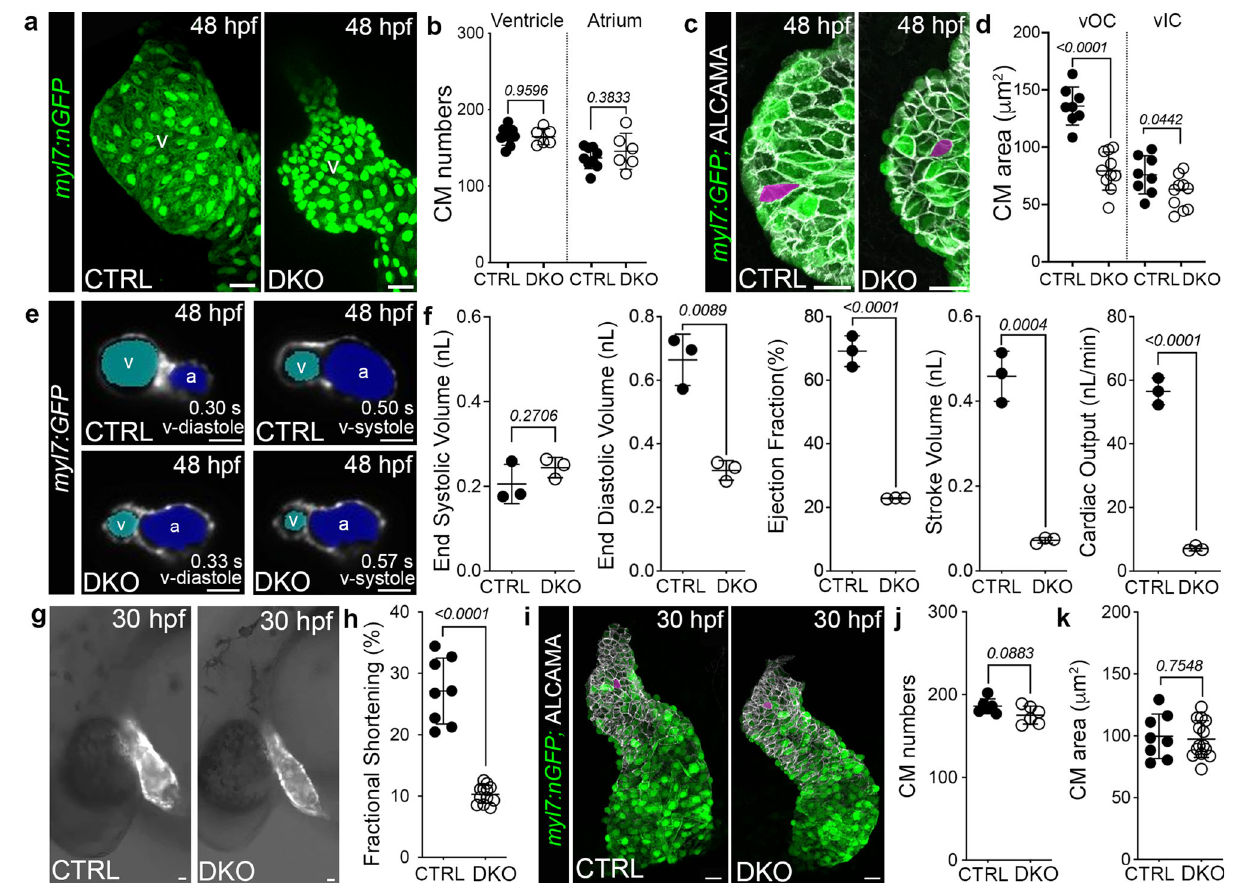
Fig. 3 | Impaired myocardial function is the earliest cardiovascular defect observedinRbfox-de fi cientembryos.a Confocalprojectionsof48hpfCTRLand DKO hearts carrying the Tg ( myl7:nGFP) transgene immunostained for GFP (green). b Dot plot showing cardiomyocyte numbers. c Confocal projections of 48hpf ventricular OCs from CTRL and DKO embryos carrying the Tg ( myl7:GFP) reporter immunostained for GFP (green) and ALCAMA (white). Magenta overlay of OC cardiomyocytes. d Dot plot showing the average area of ventricular OC and IC cardiomyocytes. e Single-plane images of 48hpf CTRL and DKO embryos carrying the Tg(myl7:GFP) transgene. Atrial (blue) and ventricular (cyan) lumens are shown. f Dotplotsshowingventricularend-systolicvolume(ESV)andend-diastolicvolume (EDV)measuredwithCFINthatwereusedtocalculateejectionfraction(EF),stroke volume(SV),andcardiacoutput(CO). g Bright fi eldimageswith fl uorescentoverlay of Tg(myl7:GFP) reporter signal in 30hpf CTRL and DKO embryos. h Dot plot